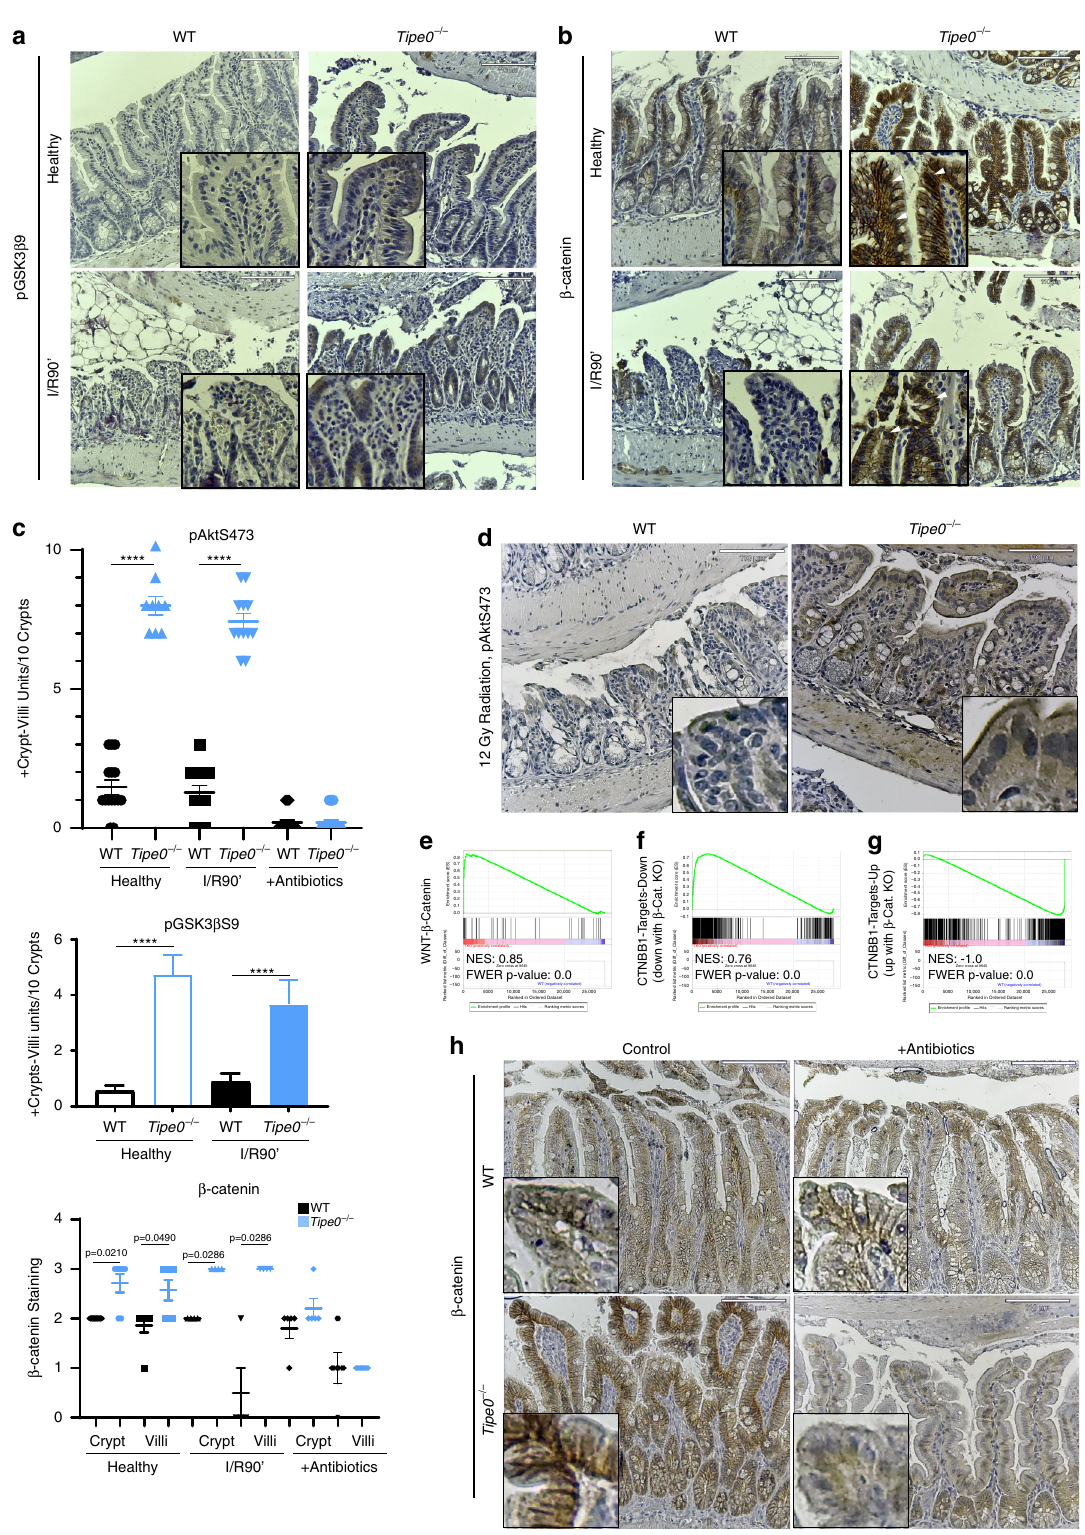
Sample collection for frozen section slides . The colon and/or small intestine was dissected and fl ushed with ice-cold PBS, longitudinally splayed, swiss rolled, snap frozen in a isopentane and dry ice mixture, embedded in OCT compound, and then sectioned with a cryostat. Tissue was then mounted on gelatin-coated histo- logical slides and stored at − 70 °C. Sample collection for paraf fi n-embedded slides . Mice were anesthetized using iso fl urane, and then sacri fi ced by cervical dislocation. The intestine was dissected